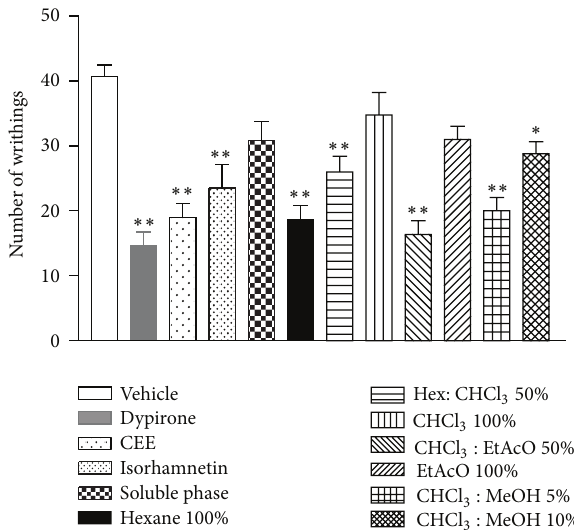
Figure 2: Antinociceptive effect of extract, fractions, and isorham- netin (100mg/kg, p.o.) on the acetic acid-induced writhings in mice. Each column represents the mean ± S.E.M. of 6 animals. Statistical differences between the treated and the control groups were evaluated by ANOVA and Dunnett hoc tests, and the asterisks denote the significance levels in comparison with control groups: ∗ 𝑃 < 0.05 ; ∗∗ 𝑃 < 0.01